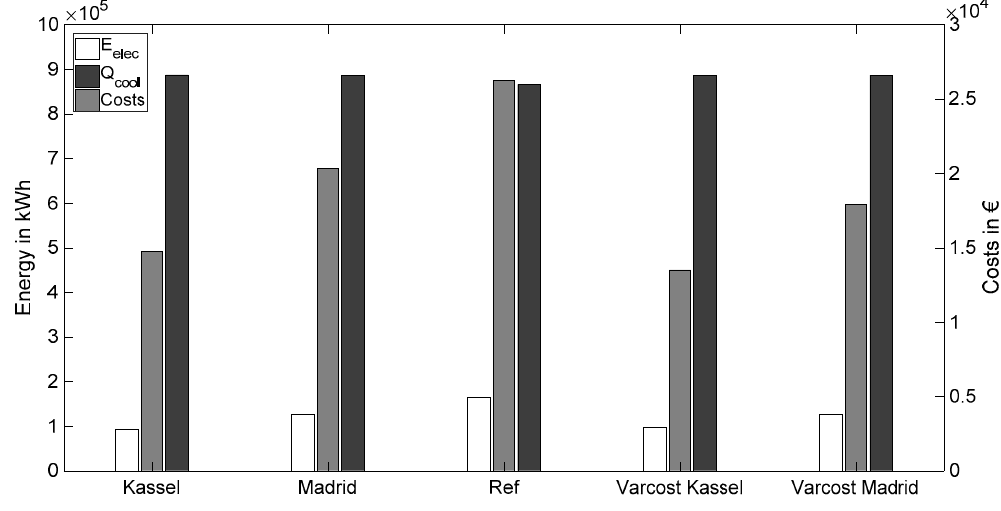
Figure 9. Comparison of variable and fixed price